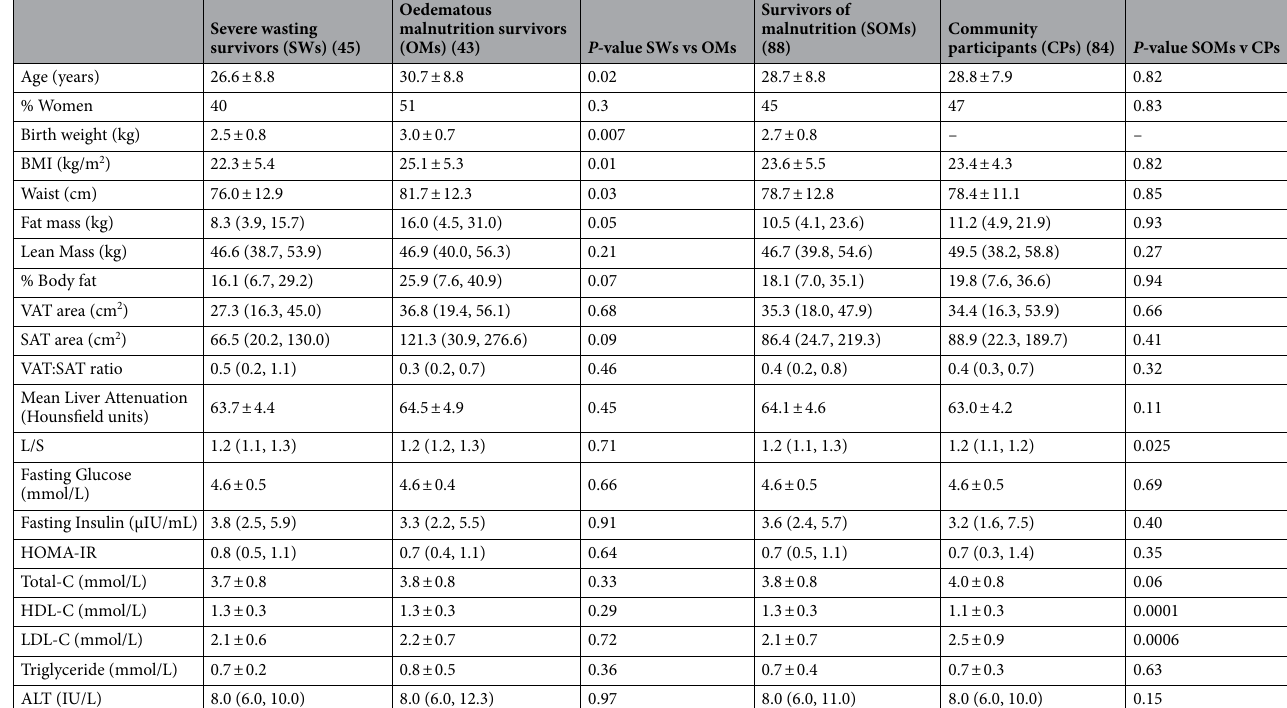
Table 1. Clinical and metabolic characteristics of 88 Afro-Caribbean adult survivors of severe malnutrition (SOMs) and 84 community participants (CPs). Characteristics of the study sample were compared by the independent sample t-test for continuous variables, and Pearson Chi square test for categorical variables. Normally distributed data are presented as means ± SDs and skewed data as medians (quartiles). VAT visceral adipose tissue, SAT subcutaneous adipose tissue, VAT:SAT ratio VAT/SAT, L/S liver spleen ratio, HOMA-IR homeostatic model assessment of insulin resistance, HDL-C high-density lipoprotein cholesterol, LDL-C low- density lipoprotein cholesterol, ALT alanine aminotransferase.